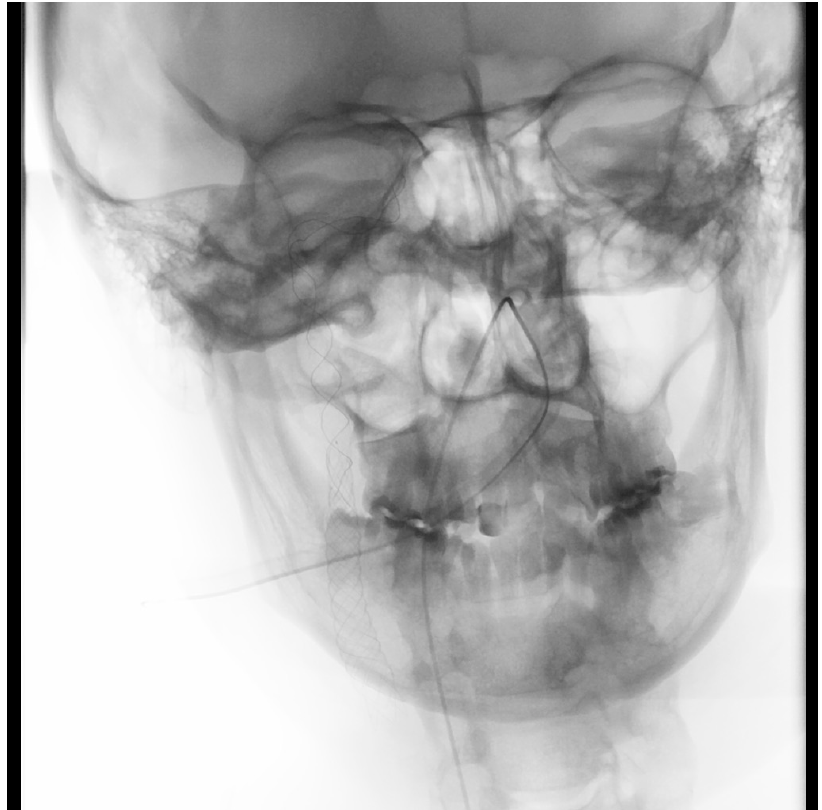
Figure 2. Stented right ICA (non DSA image).